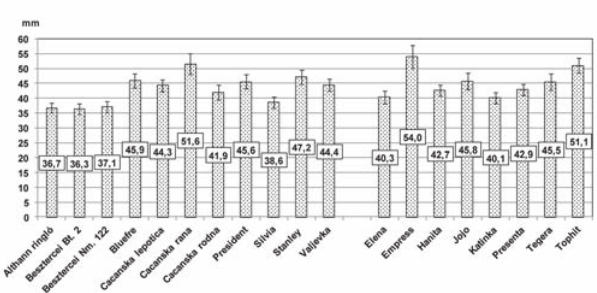
Figure 4. Mean heigth (length) of plum fruits with standard error